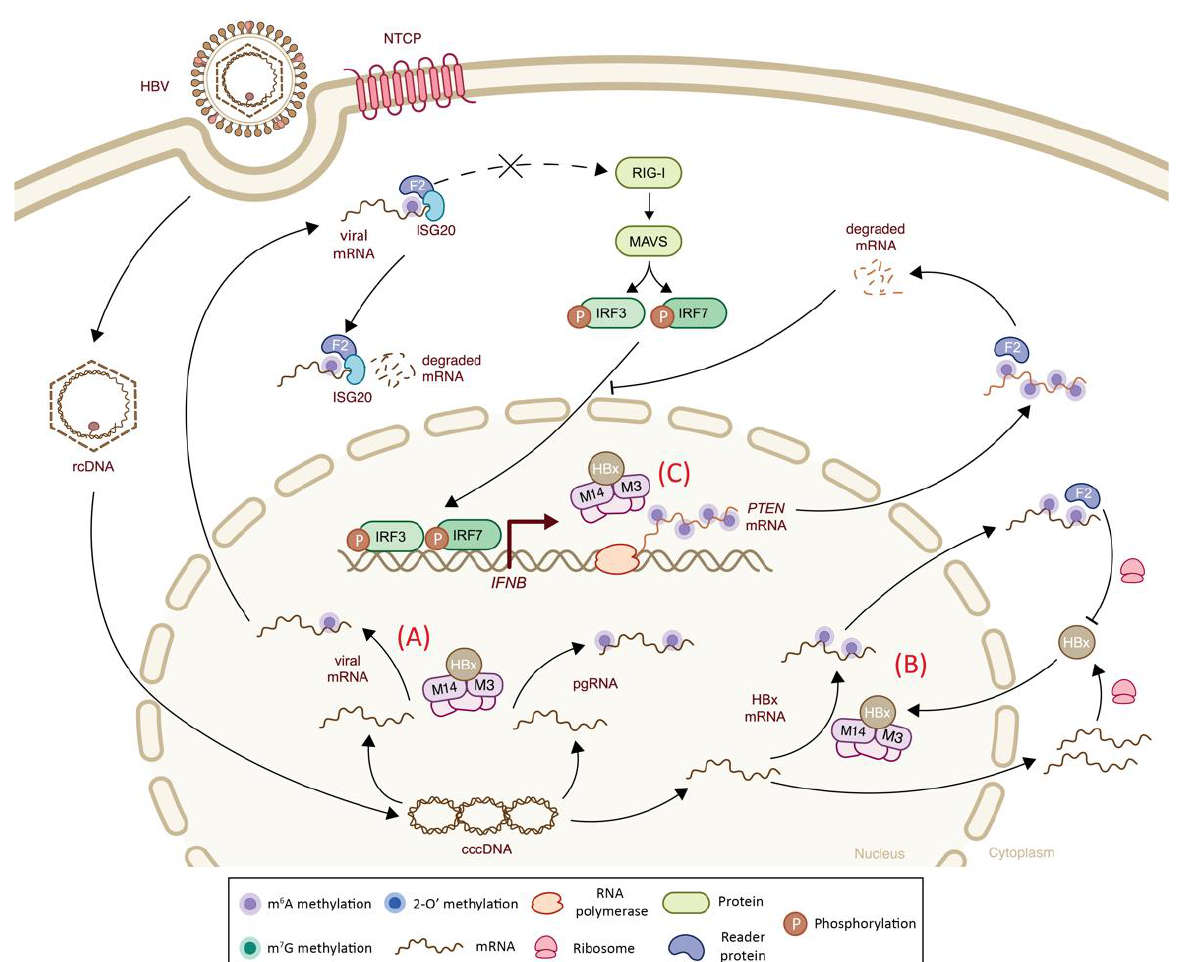
Figure 7. The impact of epitranscriptomic methylations on IFN-I response during HBV infection. Hepatitis B virus (HBV) carries a relaxed-circular DNA (rcDNA) genome that is converted into covalently closed circular DNA and transcribed into HBV RNAs upon host entry. ( A ) Viral mRNAs are co-transcriptionally m 6 A-methylated (filled purple circles) via cellular m 6 A machinery that is recruited by the viral HBx protein. M 6 A-methylated viral transcripts inhibit RIG-I sensing through m 6 A–YTHDF2 (F2, light blue) interaction. However, upon IFN α stimulation (not shown), YTHDF2 interaction with ISG20 leads to m 6 A-methylated viral mRNAs recognition and ISG20-mediated viral mRNA degradation. ( B ). HBx also alters its own methylation levels through its interactions with the m 6 A writer complex. While non-methylated HBx transcripts are translated into the HBx protein, m 6 A-methylated transcripts are degraded through the involvement of YTHDF2 protein.